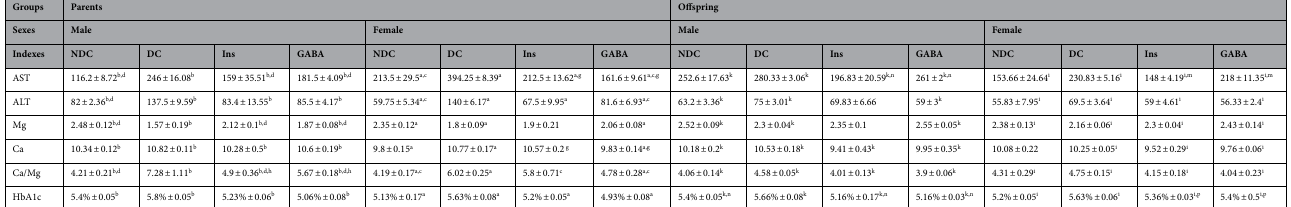
Table 3. Comparison of serum biochemical factors in male and female groups of non-diabetic control group (NDC) was fed with normal diet, diabetic control group received high-fat diet for 3 months and 35 mg/kg STZ (DC), diabetic animals treated with 1.5 gr/kg GABA via IP injection (GABA) and diabetic animals treated with insulin (2.5 U/kg twice per day) (Ins) and their offspring. (3 rats in offspring of GABA groups and 5 rats in other groups, data are expressed as mean ± S.E.M). AST aspartate aminotransferase, ALT alanine transaminase, Mg Magnesium, Ca calcium, HbA1c hemoglobin A1c. a Significant difference in serum AST, ALT, Mg, Ca, Ca/Mg and HbA1c levels between female DC group and other female groups (AST, ALT, Ca and HbA1c: ( P < 0.001); Mg: ( P < 0.01); Ca/Mg: ( P < 0.05)). b Significant difference in serum AST, ALT, Mg, Ca, Ca/Mg and HbA1c levels between male DC group and other male groups (AST, Ca/Mg and HbA1c: ( P < 0.01); ALT, Mg and Ca: ( P < 0.001)). c Significant difference in serum AST, ALT, Mg, Ca, Ca/Mg and HbA1c levels between female NDC group and other female groups ( P < 0.05). d Significant difference in serum AST, ALT, Mg, Ca, Ca/ Mg and HbA1c levels between male NDC group and other male groups (Mg: ( P < 0.001); Ca/Mg: ( P < 0.05)). g Significant difference in serum AST, ALT, Mg, Ca, Ca/Mg and HbA1c levels between female GABA group and female Ins group ( P < 0.01). h Significant difference in serum AST, ALT, Mg, Ca, Ca/Mg and HbA1c levels between male GABA group and male Ins group ( P < 0.05). i Significant difference in serum AST, ALT, Mg, Ca, Ca/Mg and HbA1c levels between female offspring DC group and other female offspring groups (AST, ALT, Mg, Ca and Ca/Mg: ( P < 0.05); HbA1c: ( P < 0.001)). k Significant difference in serum AST, ALT, Mg, Ca, Ca/ Mg and HbA1c levels between male offspring DC group and other male offspring groups (AST, ALT, Mg, Ca and Ca/Mg: ( P < 0.05); HbA1c: ( P < 0.01)). m Significant difference in serum AST, ALT, Mg, Ca, Ca/Mg and HbA1c levels between female offspring NDC group and other female offspring groups (P < 0.05). n Significant difference in serum AST, ALT, Mg, Ca, Ca/Mg and HbA1c levels between male offspring NDC group and other male offspring groups ( P < 0.001). p Significant difference in serum AST, ALT, Mg, Ca, Ca/Mg and HbA1c levels between female offspring GABA group and female offspring Ins group ( P < 0.01).